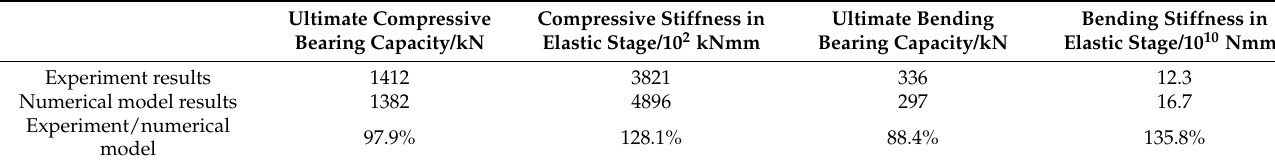
Table 8. Comparison between experimental results and FEA results.